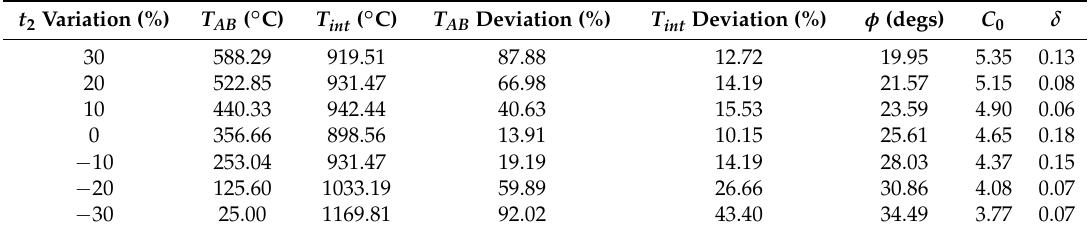
Table A2. Predicted temperatures and other variables with varying chip thickness input under test 1 cutting condition.